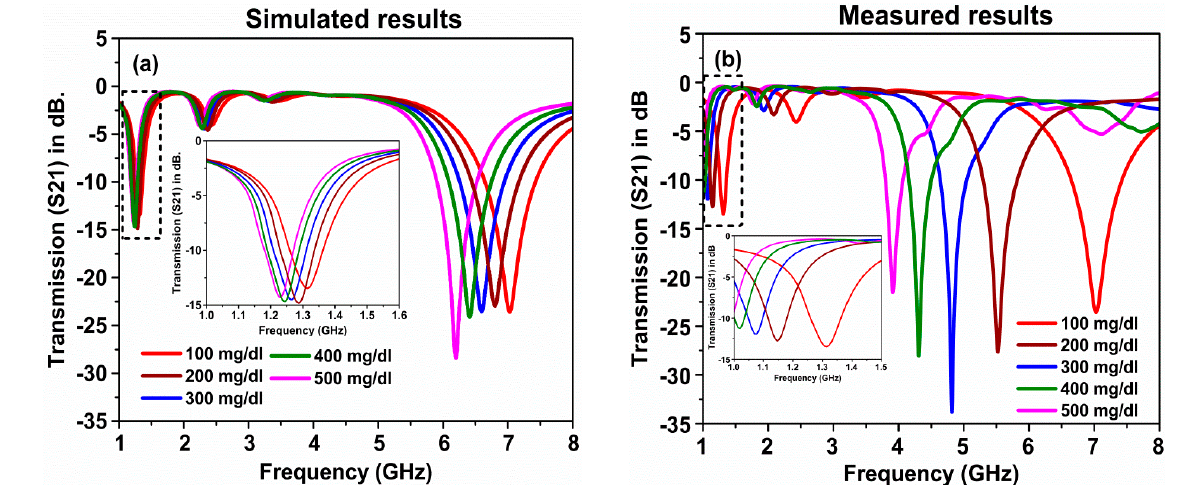
Figure 11. ( a ) Simulated and ( b ) measured results of the glucose–water mixture of the proposed metamaterials sensor.